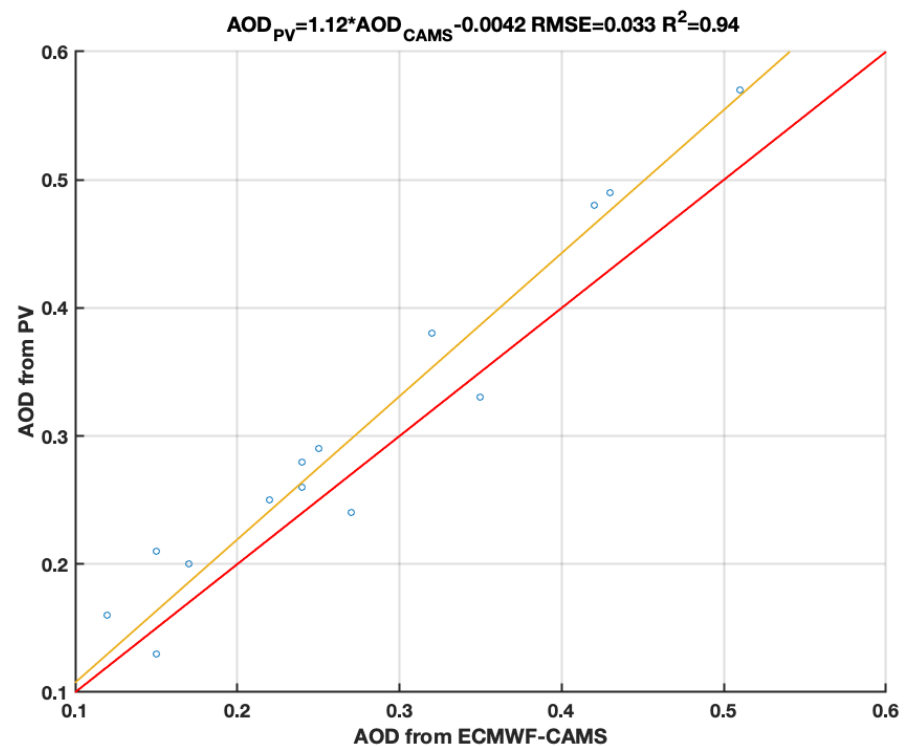
Figure 6. Intercomparison between AOD from ECMWF-CAMS reanalysis and AOD retrieved from photovoltaic panel power, as shown in Section 2.2. The linear fitting highlights that 94% of the variability can be explained by the model with a RMSE of